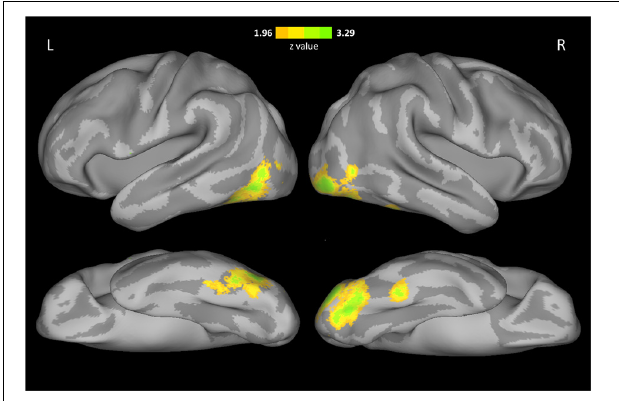
FIGURE 3 | Voxel-wise correlation between face selectivity and FRA. The results were displayed on an inflated cortical surface of MNI standard template, thresholded at z > 1 . 96 (two tailed p < 0 . 05,